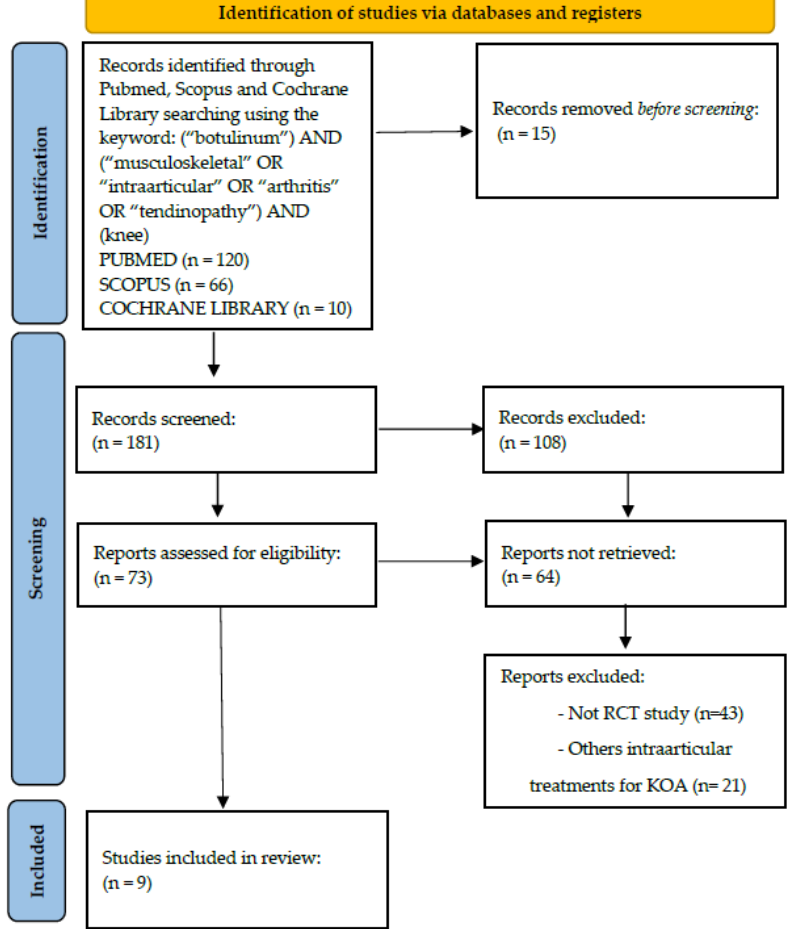
Figure 1. Preferred Reporting Items for Systematic Reviews and Meta-analyses flowchart resuming the paper’s selection process.